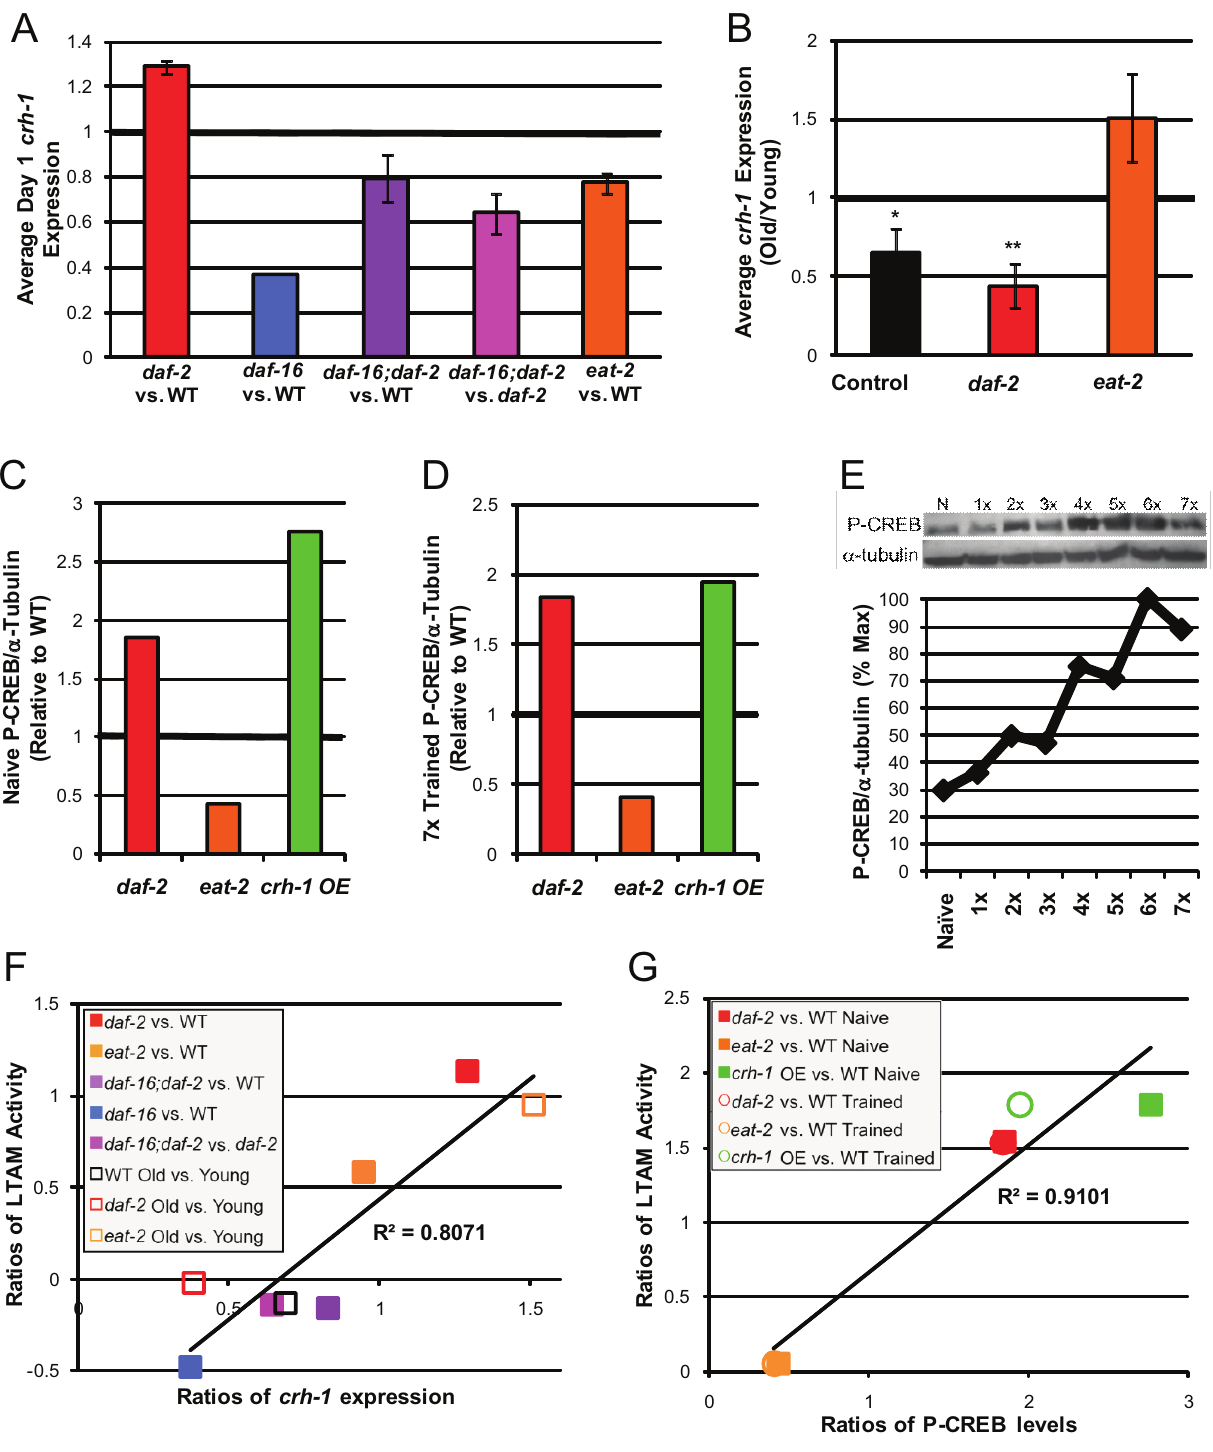
Figure 9. CREB/ crh-1 expression and P-CREB activity correlate with memory performance. (A) CREB ( crh-1 ) expression is increased in daf-2 and decreased in daf-16 , daf-16;daf-2 , and eat-2(ad465) mutant worms relative to wild type on Day 1 of adulthood. (B) crh-1 expression significantly declines in wild-type and daf- 2 worms with age but does not decline in eat-2 worms. (C–D) P-CREB levels are higher in daf-2 mutant and crh-1 - overexpressing worms and lower in eat-2 mutant worms both before (C) and after (D) 7 6 LTAM training, relative to wild type. (E) P-CREB levels increase with LTAM training. (F) crh-1 expression levels correlate with LTAM activity in longevity mutants and with age (R 2 =0.81). (G) P-CREB levels correlate with LTAM activity in longevity mutants and crh-1- overexpressing worms on Day 1 of adulthood (R 2 =0.91). (A–B, F): n $ 4 (except daf-16 expression, n =1); 6 SEM; * p , 0.05, ** p , 0.01, *** p , 0.001. (C–D, G): Western blots shown in Figure S6C,E.